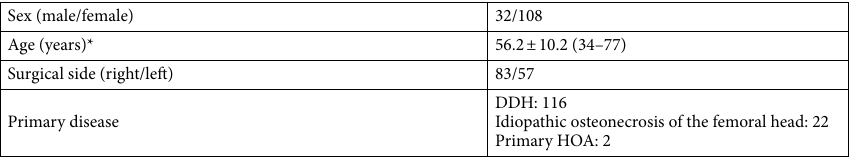
Sex (male/female)